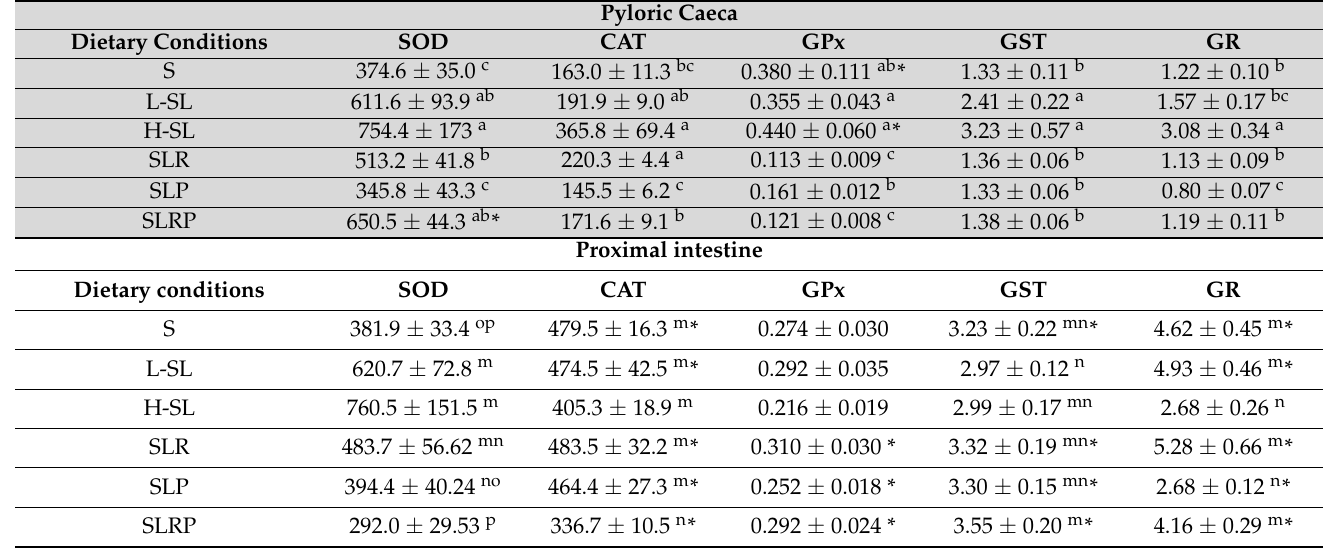
Table 5. Antioxidant enzymes activities (U × mg prot − 1 ) in pyloric caeca and proximal intestine 24 h post-feeding in sea bream fed the experimental diets.